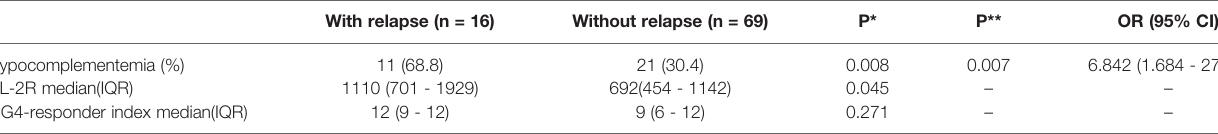
TABLE 2 | A multivariable logistic analysis between with and without relapse. With relapse (n = 16) Without relapse (n = 69) Hypocomplementemia